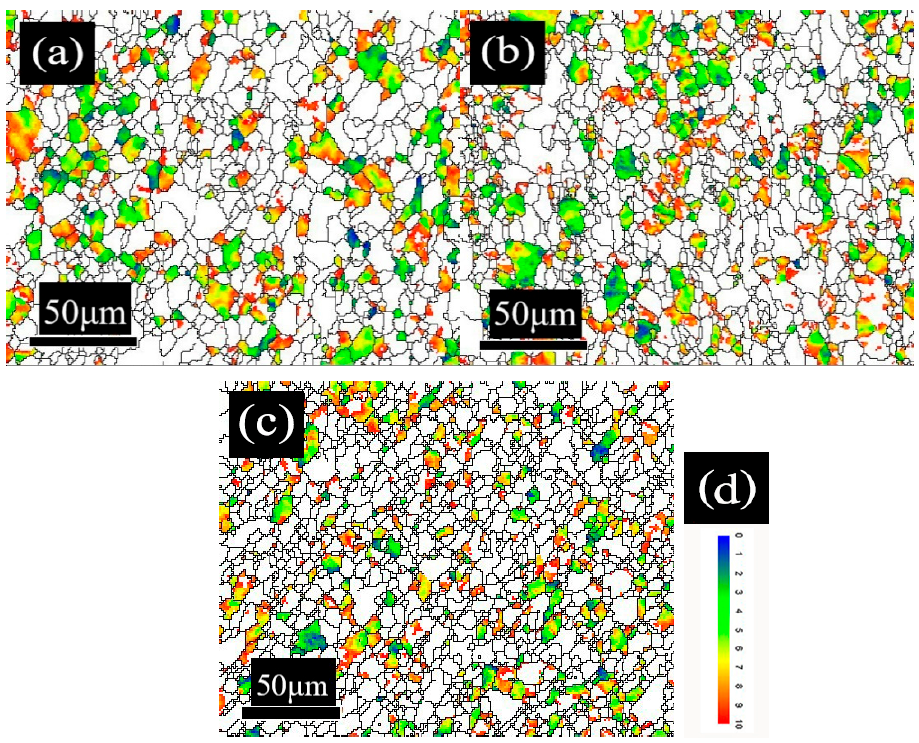
Figure 5. Misorientation distribution of desired {111} grains with different secondary cold reduction rates: ( a ) 15%; ( b ) 20%; ( c ) 25%; ( d ) color legend.